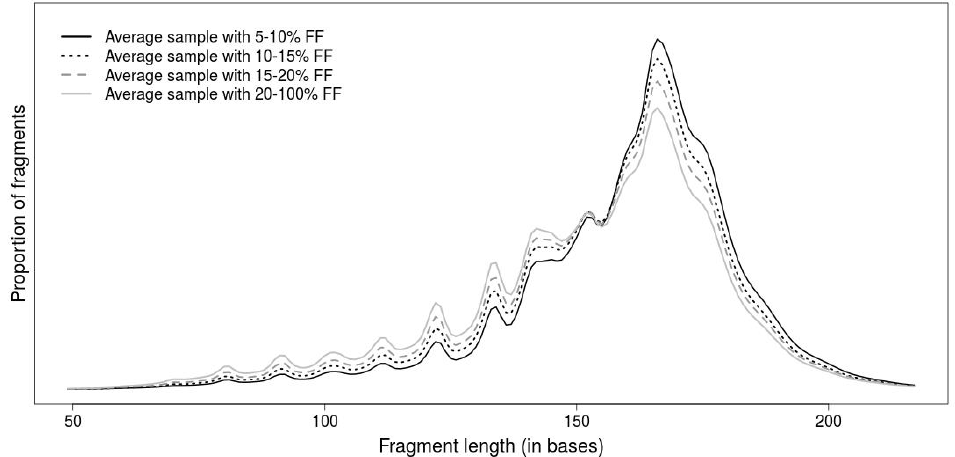
Figure 1. Average fragment-length profiles determined from samples with selected ranges of fetal fractions calculated across lengths. Samples with higher fetal fraction (FF) also have shorter fragments indicating that maternal fragments are longer than fetal